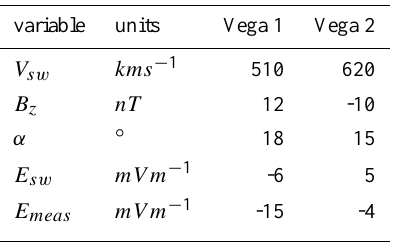
Table 1. The average induced and measured electric fields during the gas releases